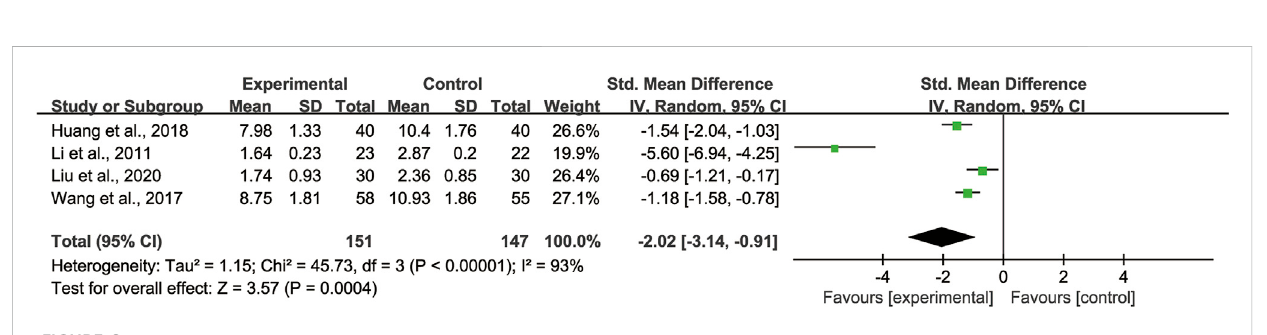
FIGURE 6 Forest plot of HRCT integral of lungs: CHMs plus CTX treatment versus CTX